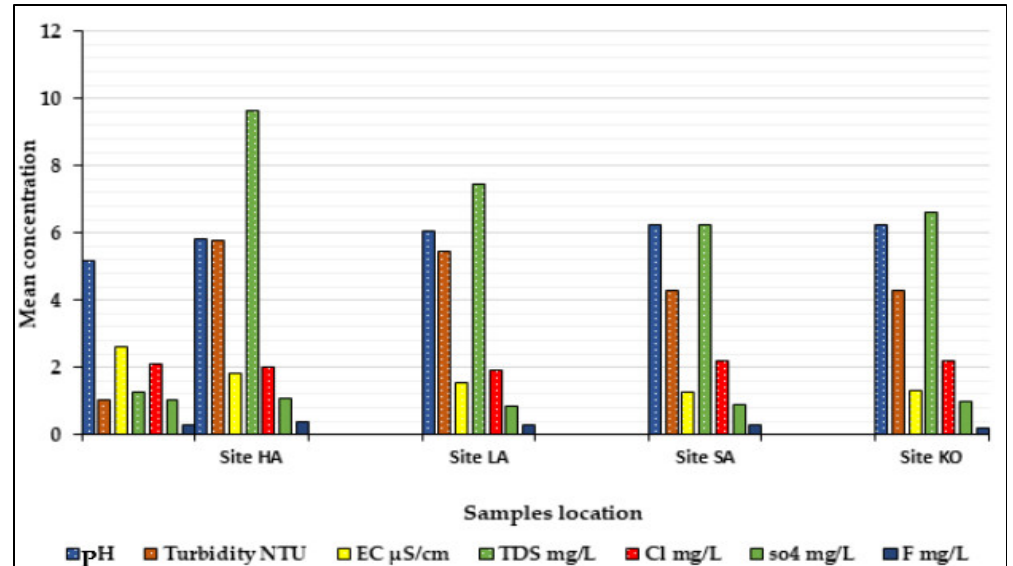
Figure 2. Physicochemical parameters of roof-harvested